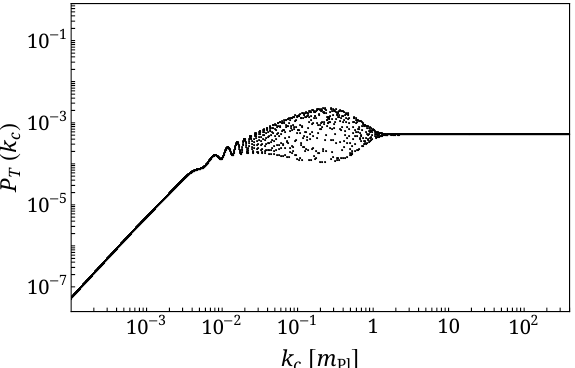
Figure 7. Primordial tensor power spectrum associated with an evolution with a bounce identical to the reference case, i.e., C = 1, σ = 2, and B = 0.4, but shifted to µ = −